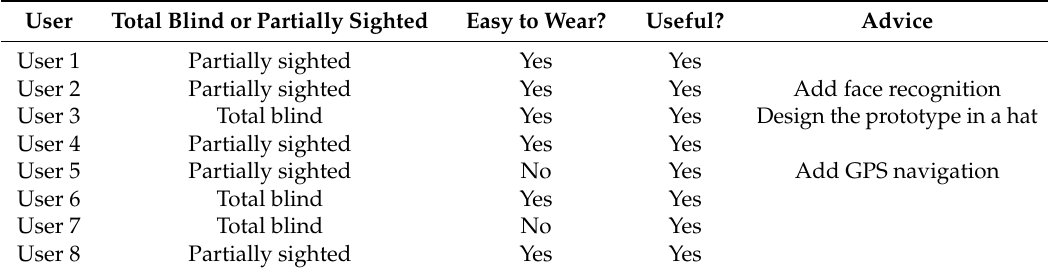
Table 4. A questionnaire. After the test, eight participants were asked two simple questions.